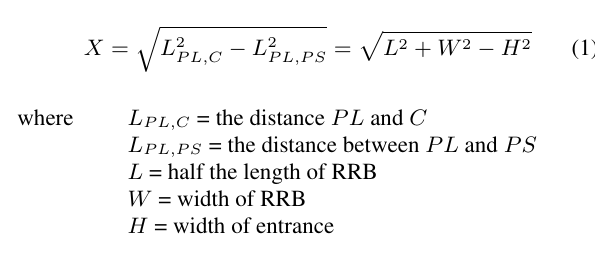
Figure 5. The trajectory and required space of RRB with a rotation centre. The line with the centre of RRB is the trajectory and the space between the two dash lines is the required space.